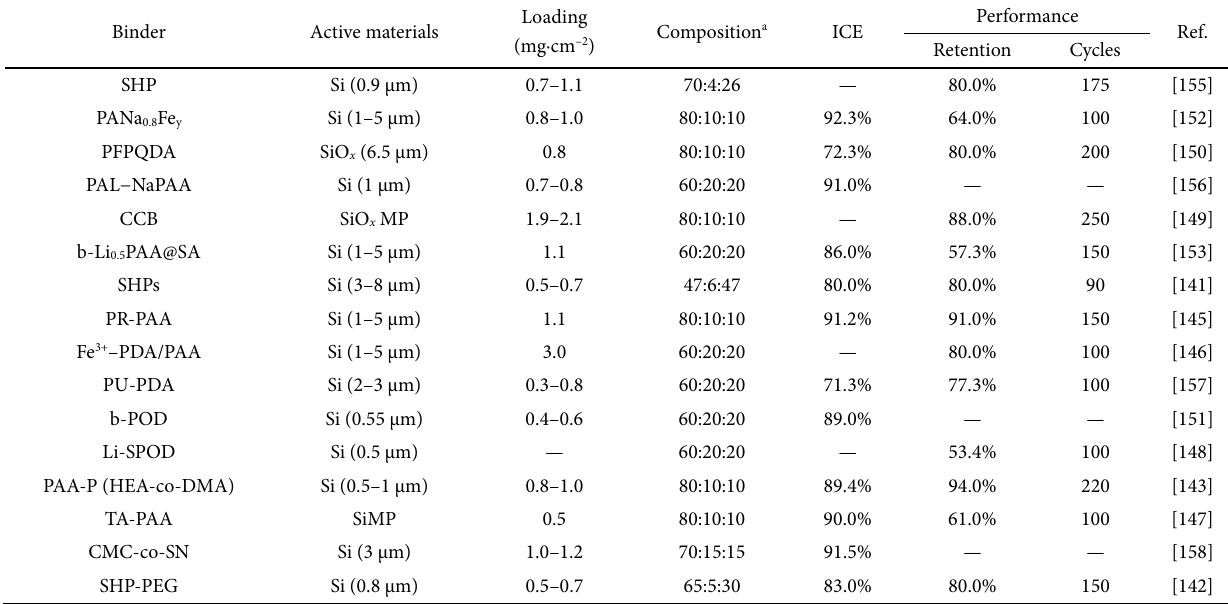
Table 3 Binders for SiMP anodes Binder Active materials